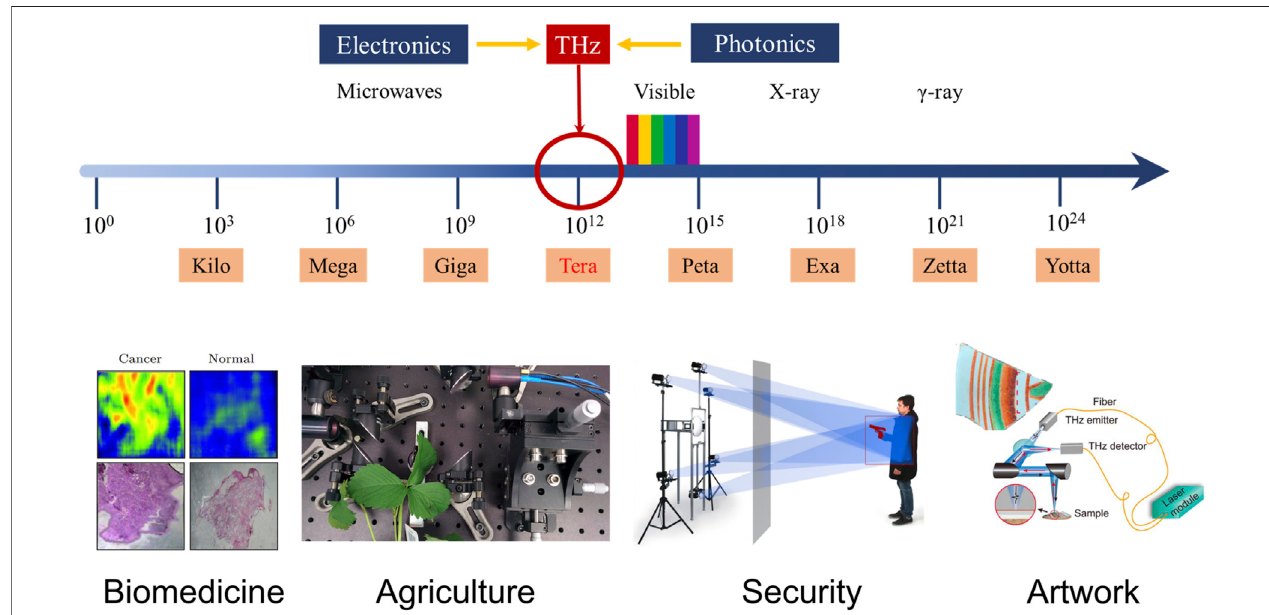
FIGURE 1 | Terahertz spectroscopy and some typical applications [1, 22, 25, 29, 30]. Reproduced with permissions. © 2013 Chinese Physical Society and IOP Publishing Ltd. © 2017 IEEE. © 2020 Springer Science Business Media, LLC, part of Springer Nature. © 2021 The Japan Society of Applied